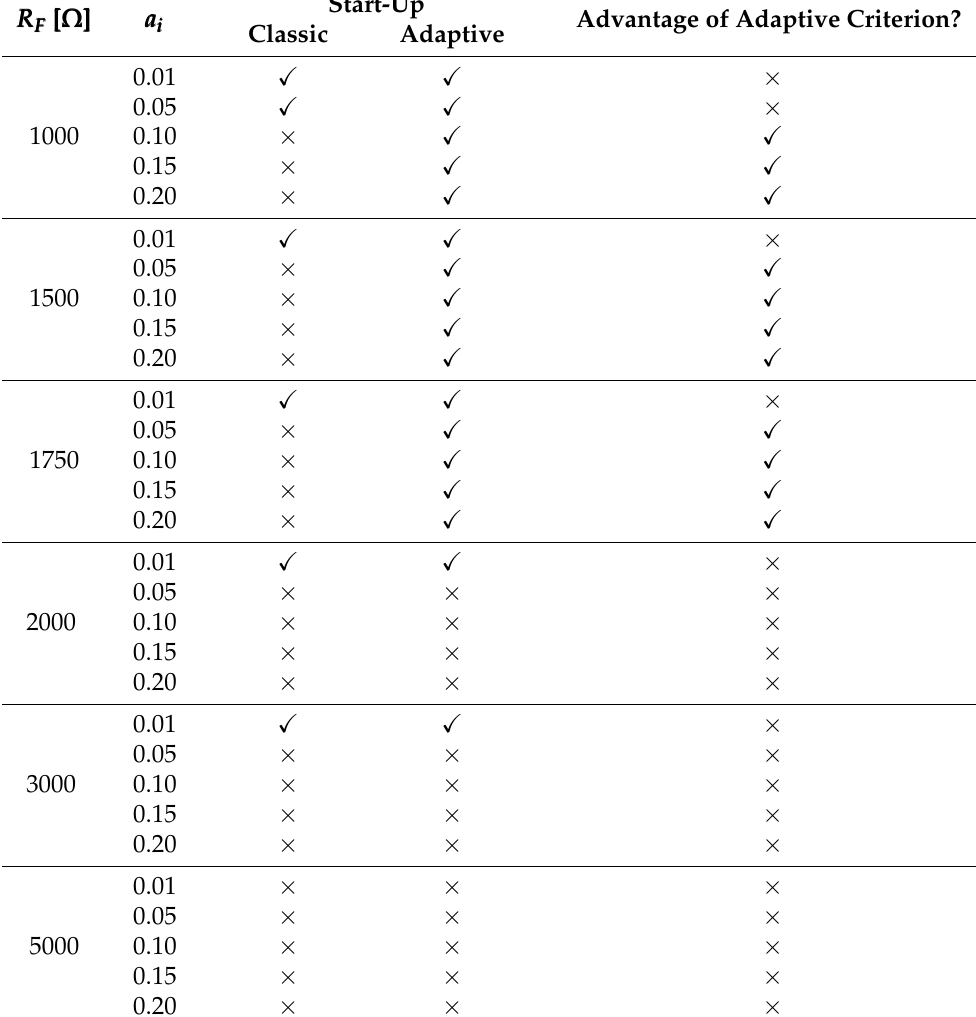
Table 7. Comparison of the effectiveness of the zero-sequence adaptive criterion and classical zero- sequence current